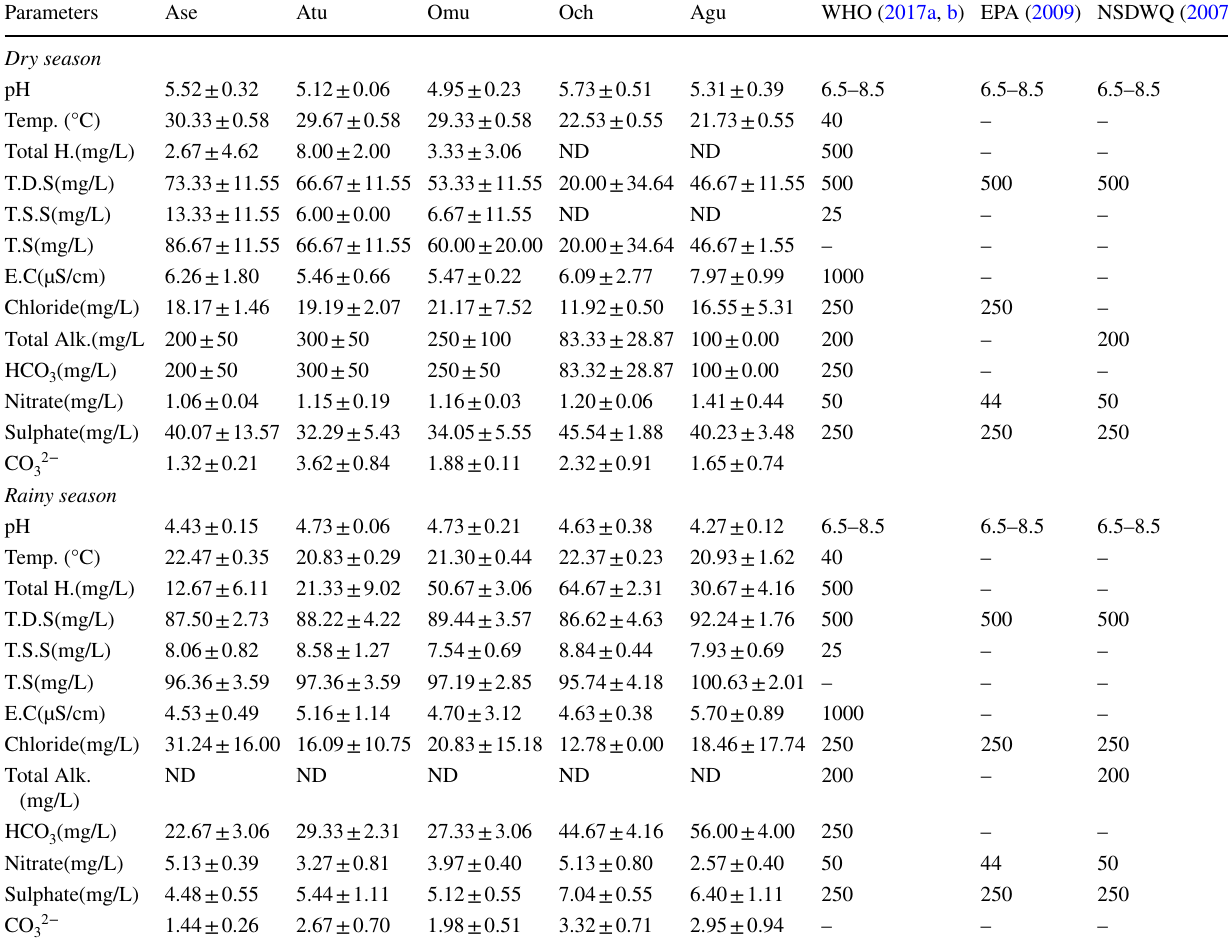
Table 3 Physicochemical Parameters (mean ± SE) of the spring water